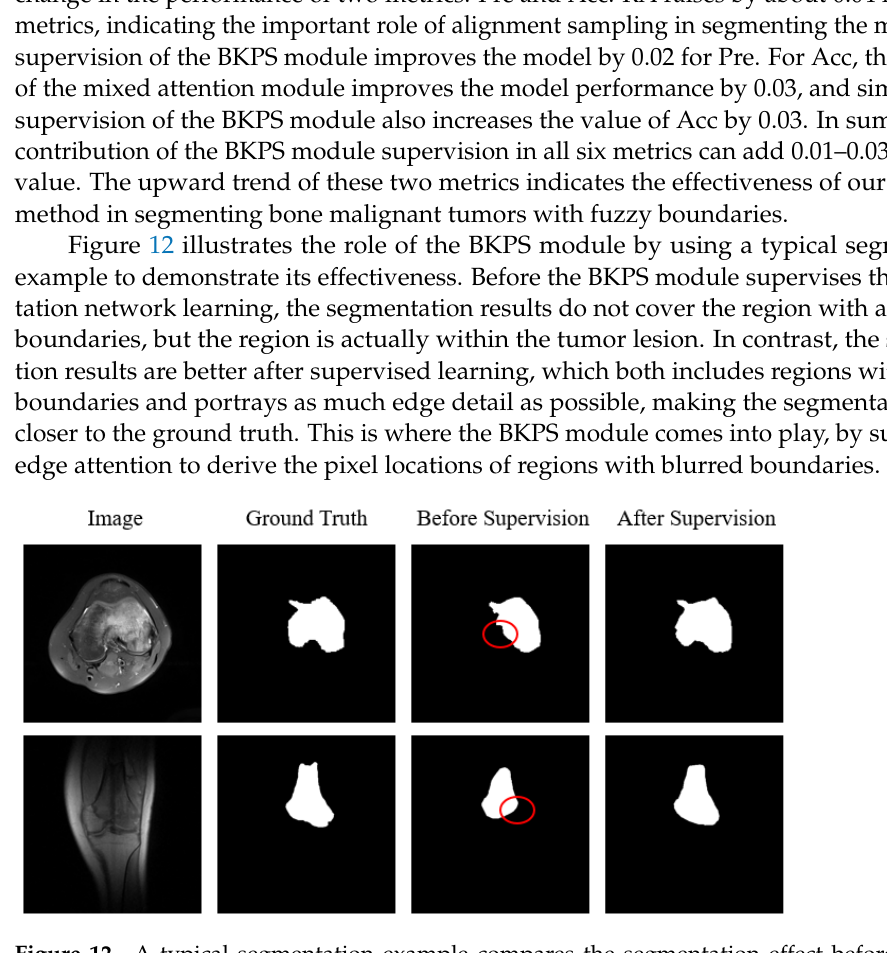
Figure 12. A typical segmentation example compares the segmentation effect before and after applying the BKPS module to supervise edge attention learning. The red circles mark the regions of tumor lesions with ambiguous boundaries that were not captured in the segmentation network before supervision.